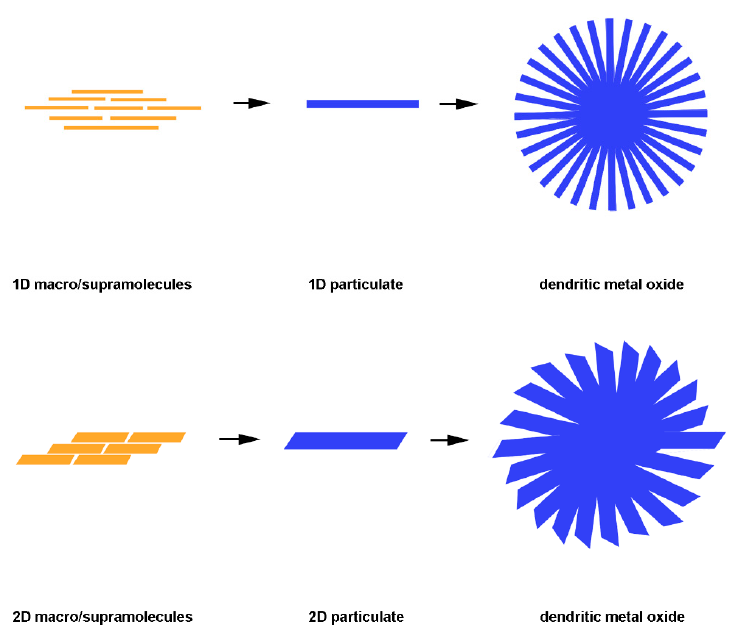
Figure 1. Examples of dendritic oligomers that are used to modify ceramic filters to remove organic contaminants from water [10].